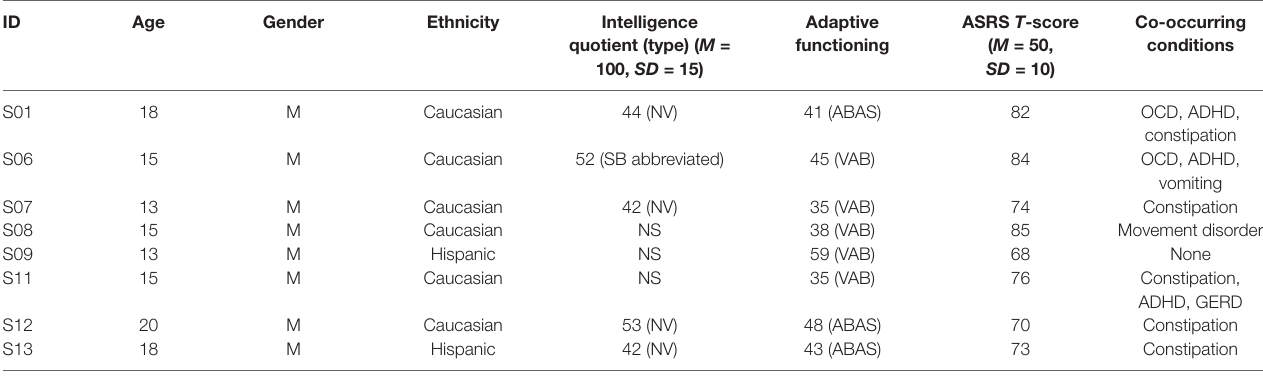
TABLE 1 | Participant demographics and descriptive